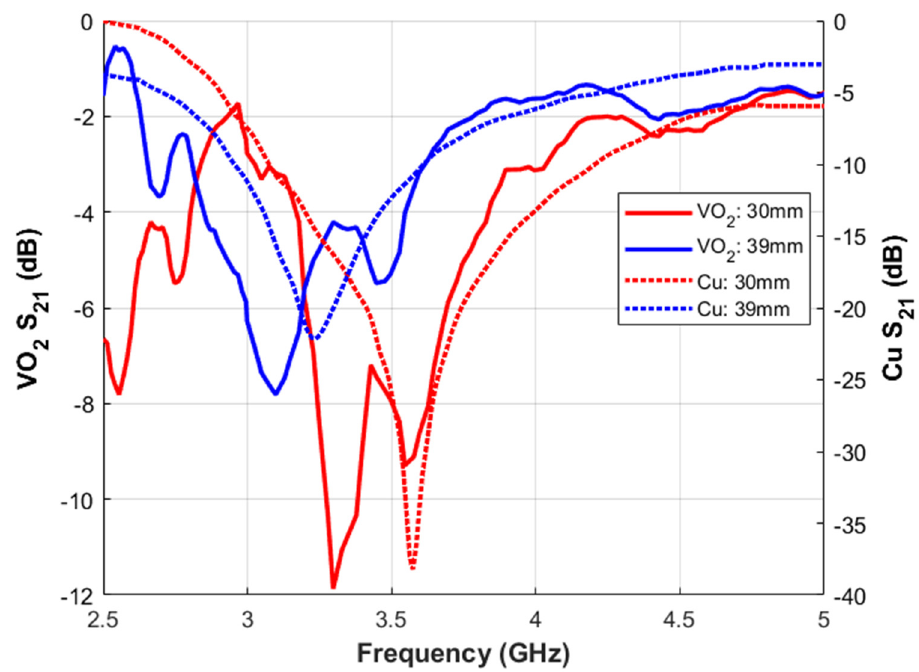
Figure 9. The graph of the measured transmission coefficient of single dipole element of VO 2 and Cu for lengths 30 and 39 mm.